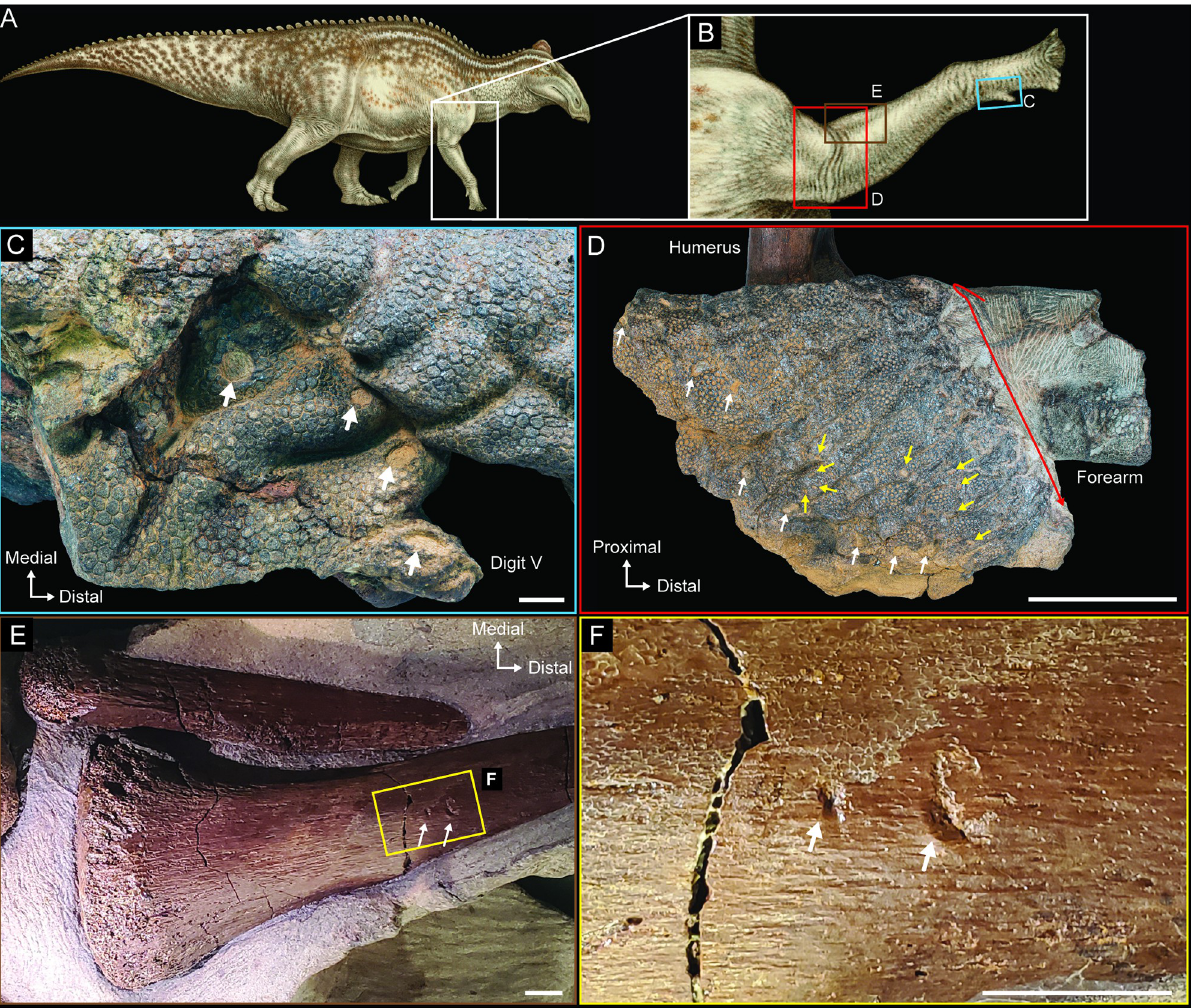
Fig 5. Evidence of soft tissue and bone modifications in NDGS 2000. (A) NDGS 2000 reconstruction in right lateral view. (B) Right forearm in right lateral view indicating the positions of the close-up views in C-H. (C) Dorsal view of manual digit V with white arrows showing a set of punctures in the skin. (D) Right lateral view of right elbow region showing the internal surface of the skin that was degloved from around the right humerus. White arrows highlight positions of larger punctures in the skin, yellow arrows highlight positions of smaller punctures in the skin, and the red arrow indicates the folded edge of the skin flap. (E) Proximal portion of right radius in anterolateral view exposed through a rip in the skin with white arrows highlighting the placement of pits on the bone surface. (F) Close-up view of pits (white arrows) on the right radius shown in (E). Paleoart in (A) by Natee Puttapipat. Scale bar in D equals 10 cm, all other scale bars equal 1 cm.